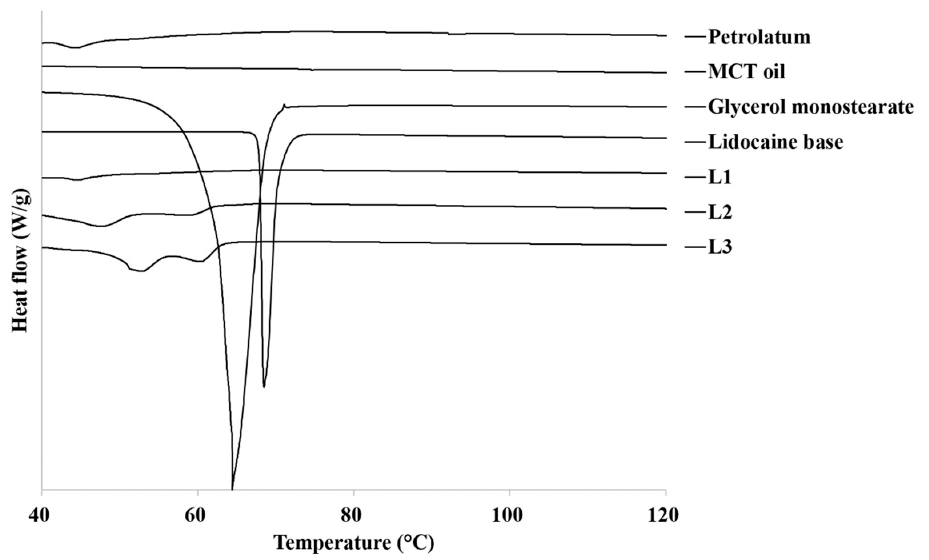
Figure 1. DSC thermograms of raw materials and prepared lidocaine ointments. MCT, medium ‐ chain triglyceride.